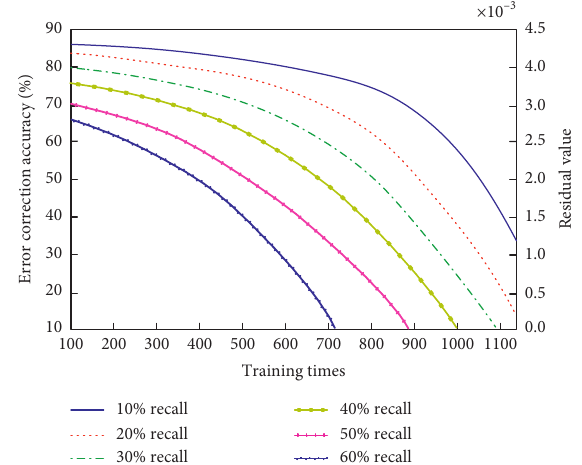
Figure 5: Relationship between grammar error correction accuracy and residual value and algorithm training time with different recall